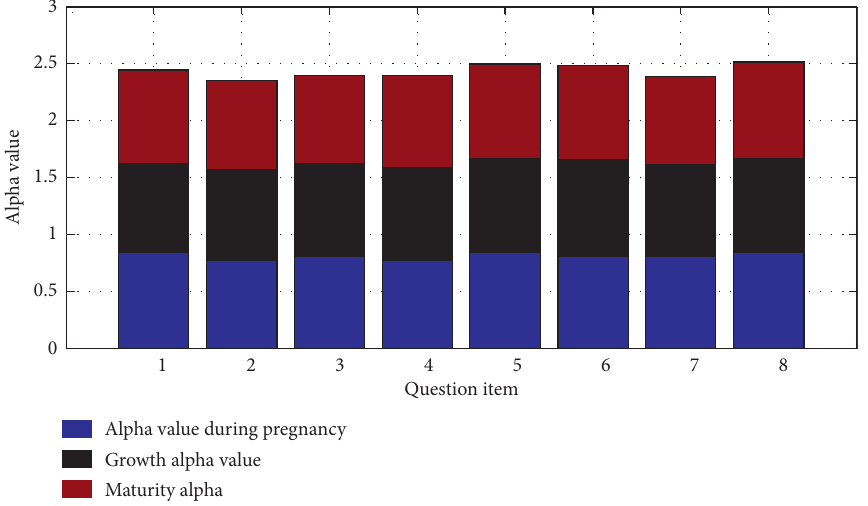
Figure 5: Reliability analysis results of the scale.